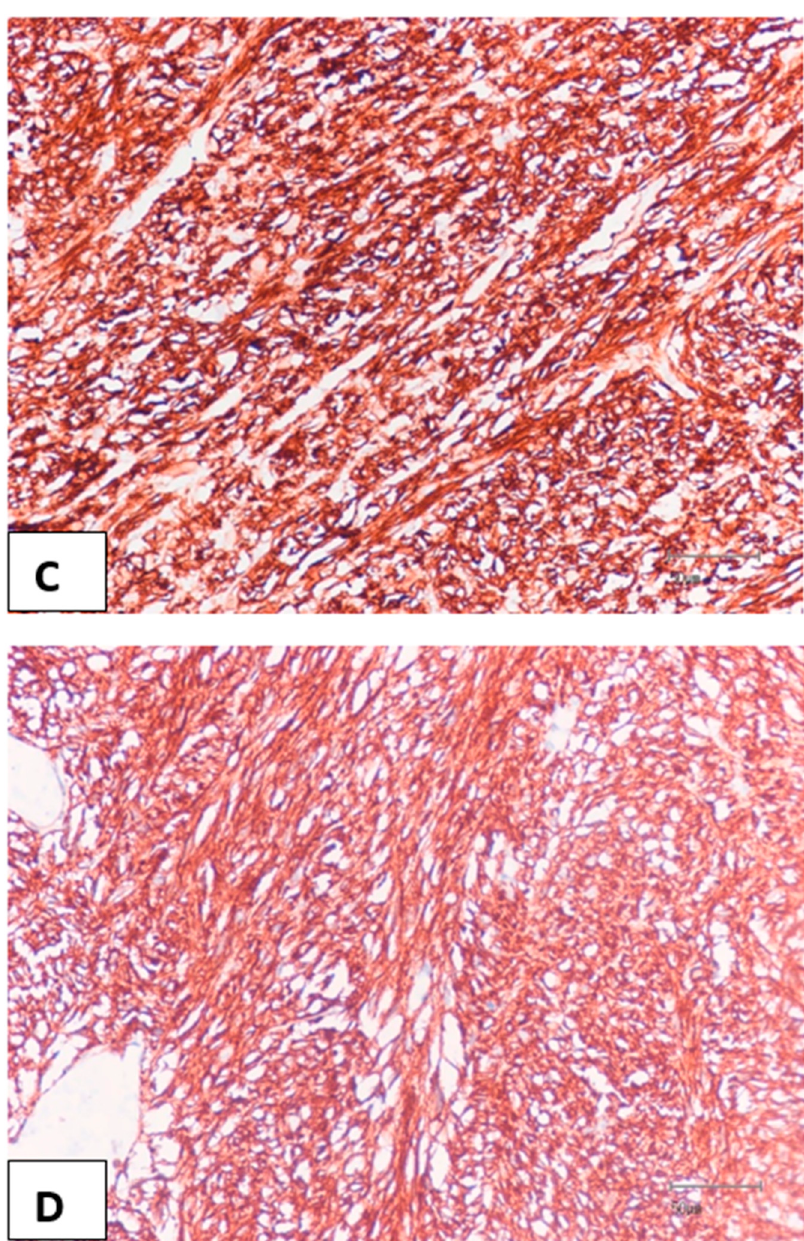
Figure 2. Two nodular neoplasms close to each other ( A ), consisting of spindle cells without significant atypia or pleomorphism ( B ), proven to be GISTs positive for CD117 ( C ) and DOG-1 ( D ) antibodies, (( B ) Hematoxylin-Eosin X200; ( C , D ) Immunohistochemistry X200).